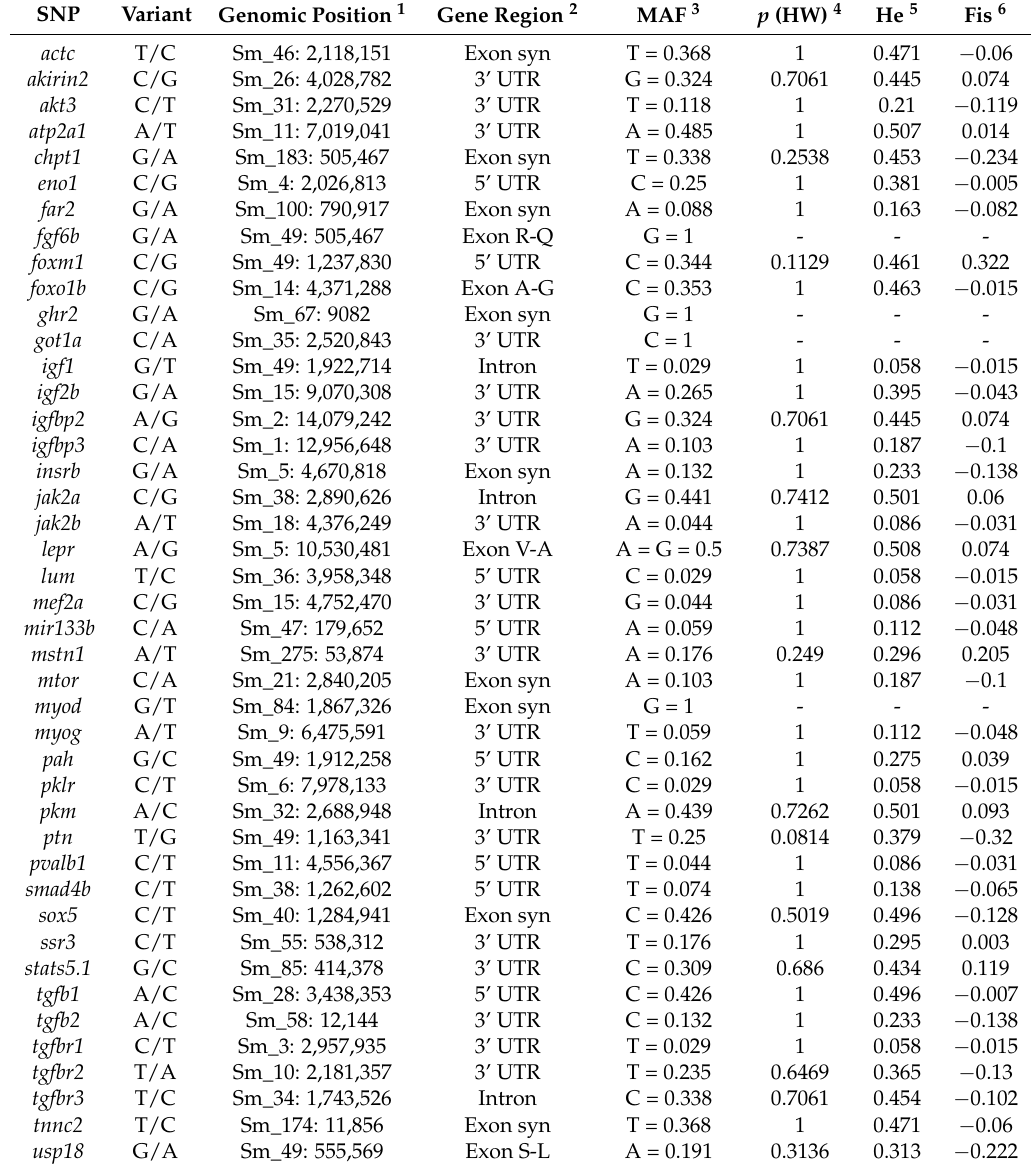
Table 3. SNP markers for growth-related genes in